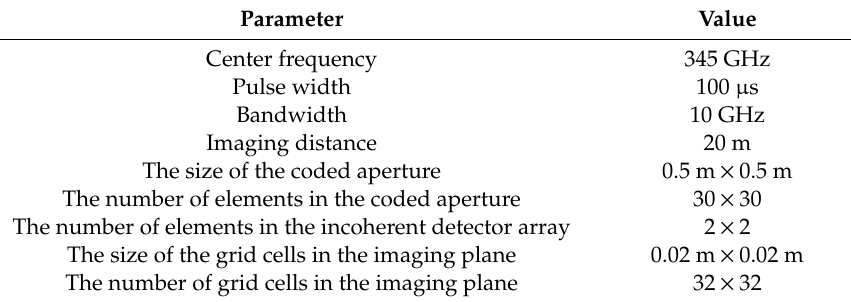
Table 1. Basic parameter settings used in the